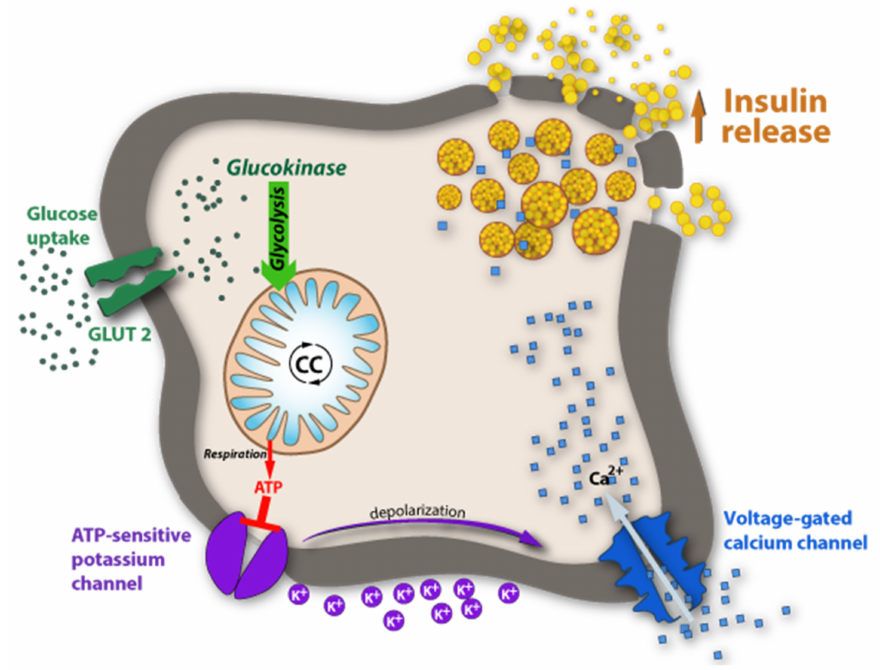
Figure 10. Glucose-sensing by glucokinase. The insulin release is stimulated by high plasma glucose concentrations triggered by a signaling pathway in pancreatic islets through ATP biosynthesis during glycolysis. For details see